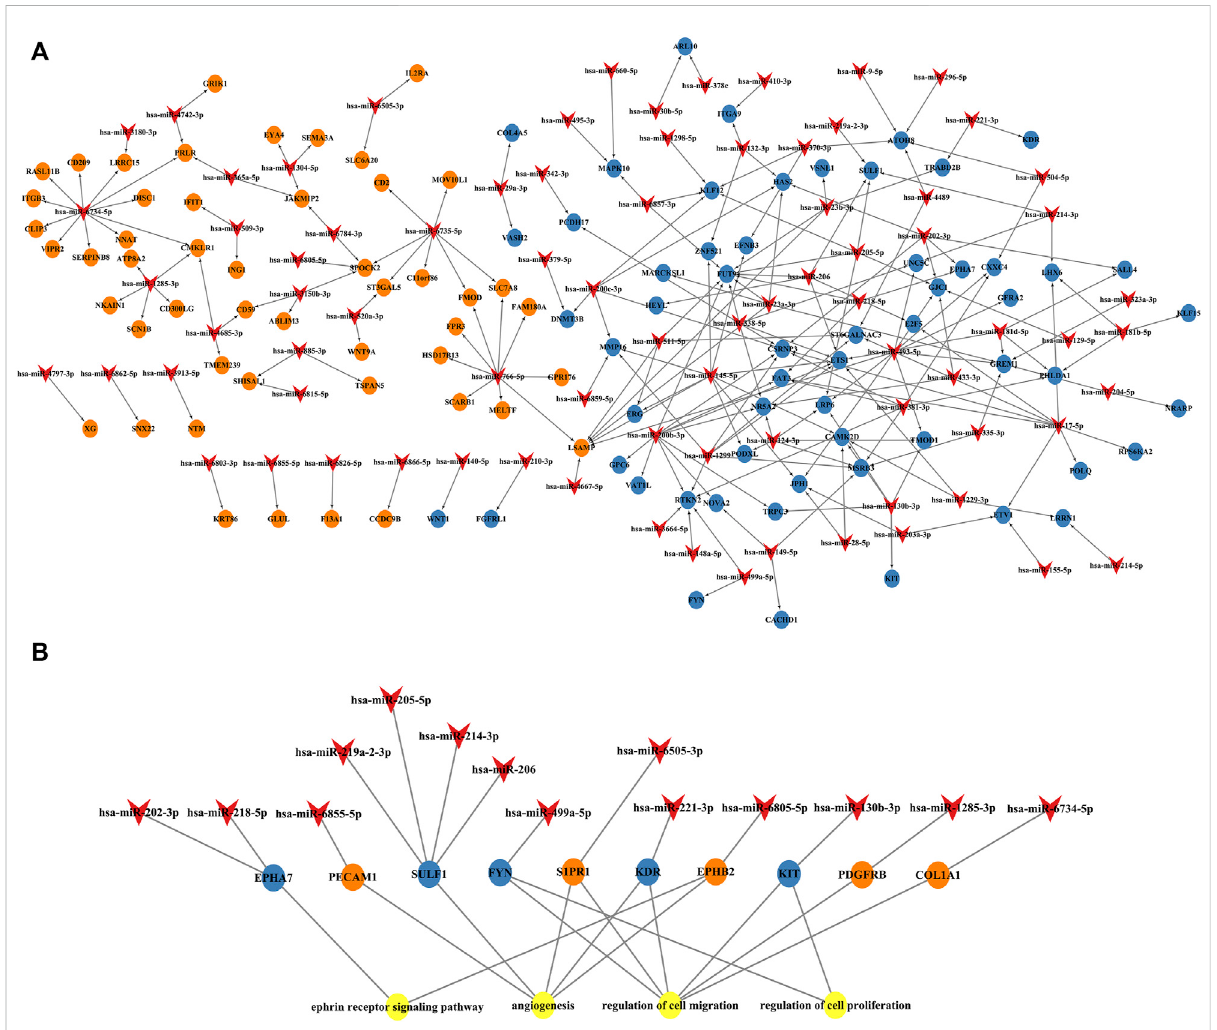
FIGURE 6 miRNAandmRNAnetwork. (A) ConstructionofmiRNA-overlappinggenesregulatorynetwork.Thediamondrepresentsdifferentiallyexpressed circulating miRNAs, the blue circle represents downregulated overlapping genes, and the orange circle represents upregulated overlapping genes. (B) Predicted biological processes (BPs) of GO involving top 10 hub genes regulated by differentially expressed plasma miRNAs in RPL patients.